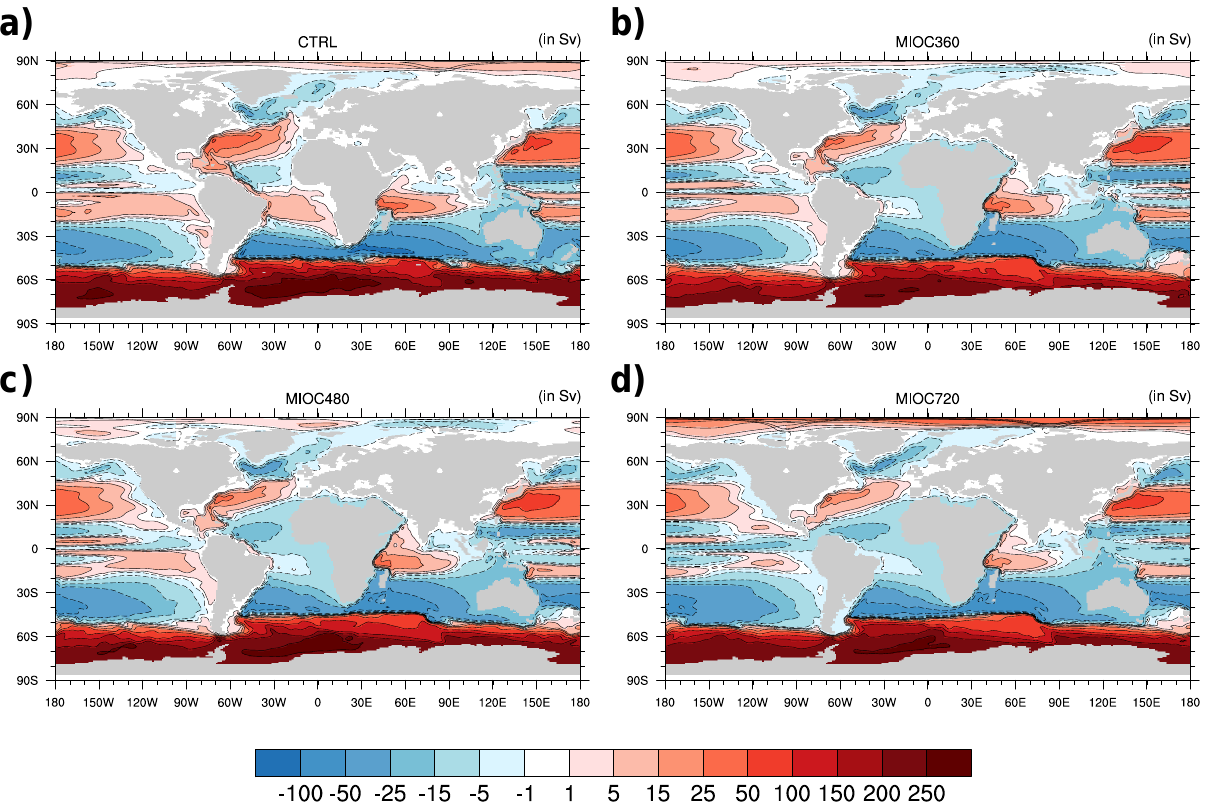
Fig. 11. Horizontal ocean circulation in the Atlantic Ocean in terms of the barotropic streamfunction for (a) CTRL, (b) MIOC360, (c) MIOC480, and (d) MIOC720 (in